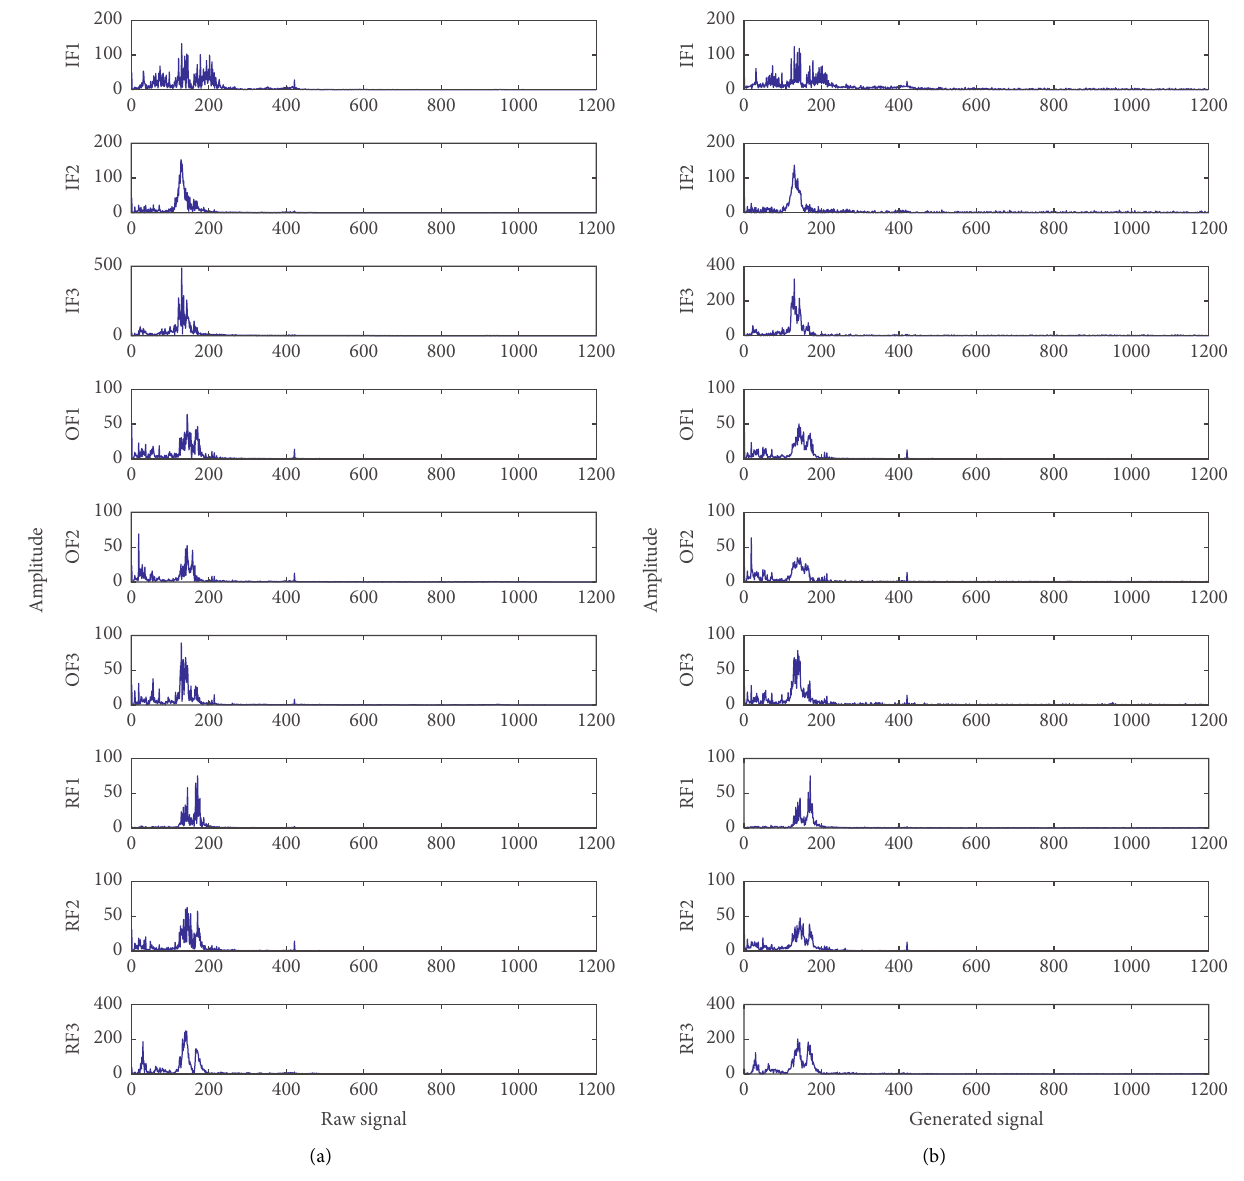
Figure 3: Spectrum comparison between real and generated signals.